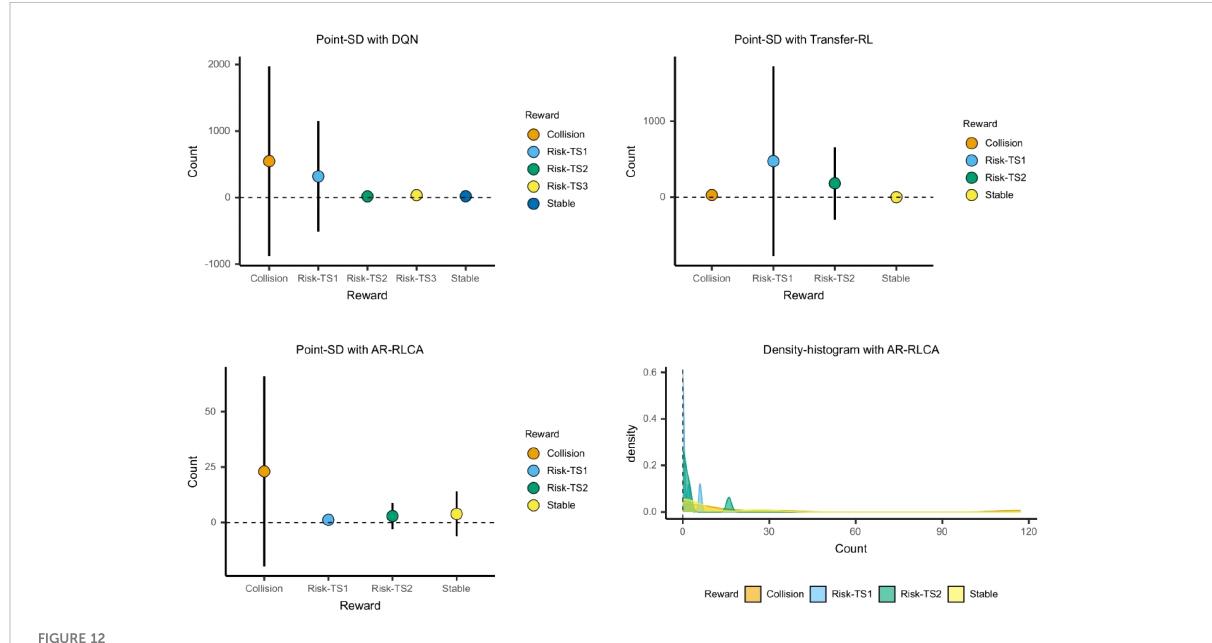
FIGURE 12 The point-SD and density chart of reward interaction.